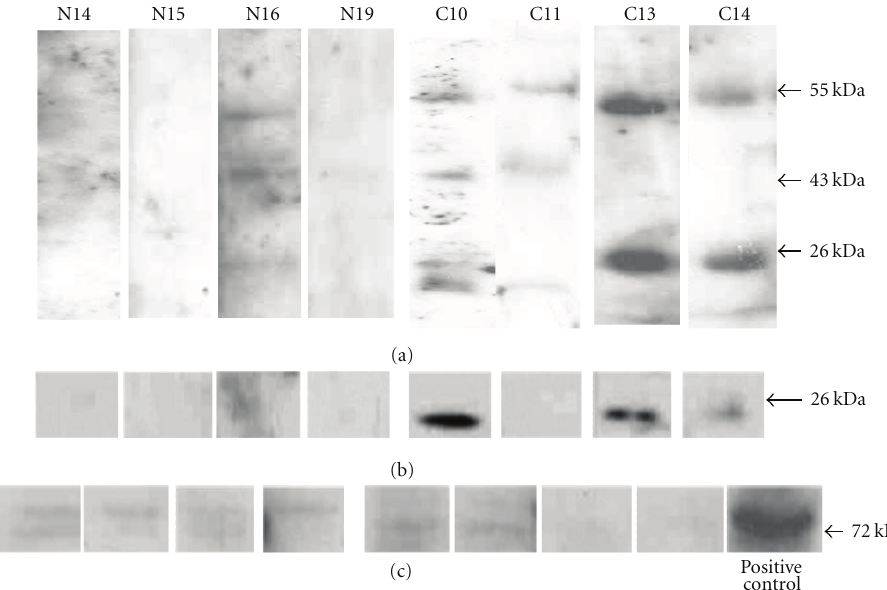
Figure 2: Detection of Antigens on erythrocyte membrane which are recognized by serum IgG. (a) autographs of western blots of membranes of erythrocytes from CML patients designated C, and controls (N) stained with IgG separated from sera of the respective individual have been shown. A 43kDa fragment is stained in normal and a larger number of CML while fragments at 55 and 26 kDa are stained mainly in CML erythrocytes. The antigens are identified as fragment of band 3 (43kDa), myeloperoxidase (55kDa), and cathepsin G (26kDa) by mass spectrometry (details in Table 1). (b) The identity of cathepsin G was validated by immunostaining of western blots of erythrocyte membranes with cathepsin G-specific antibody. CML samples show higher expression of cathepsin G. (c) Immunostaining of blotted proteins from cytosol of normal and CML erythrocytes with PKC β II antibody shows a low-intensity band in both. PKC β II is expressed in neutrophils but not in erythrocytes. Insignificant detection of PKC β II in both normal and CML samples rules out the detection of cathepsin G due to contamination of neutrophils in the erythrocyte preparation. Rat brain lysate is the positive